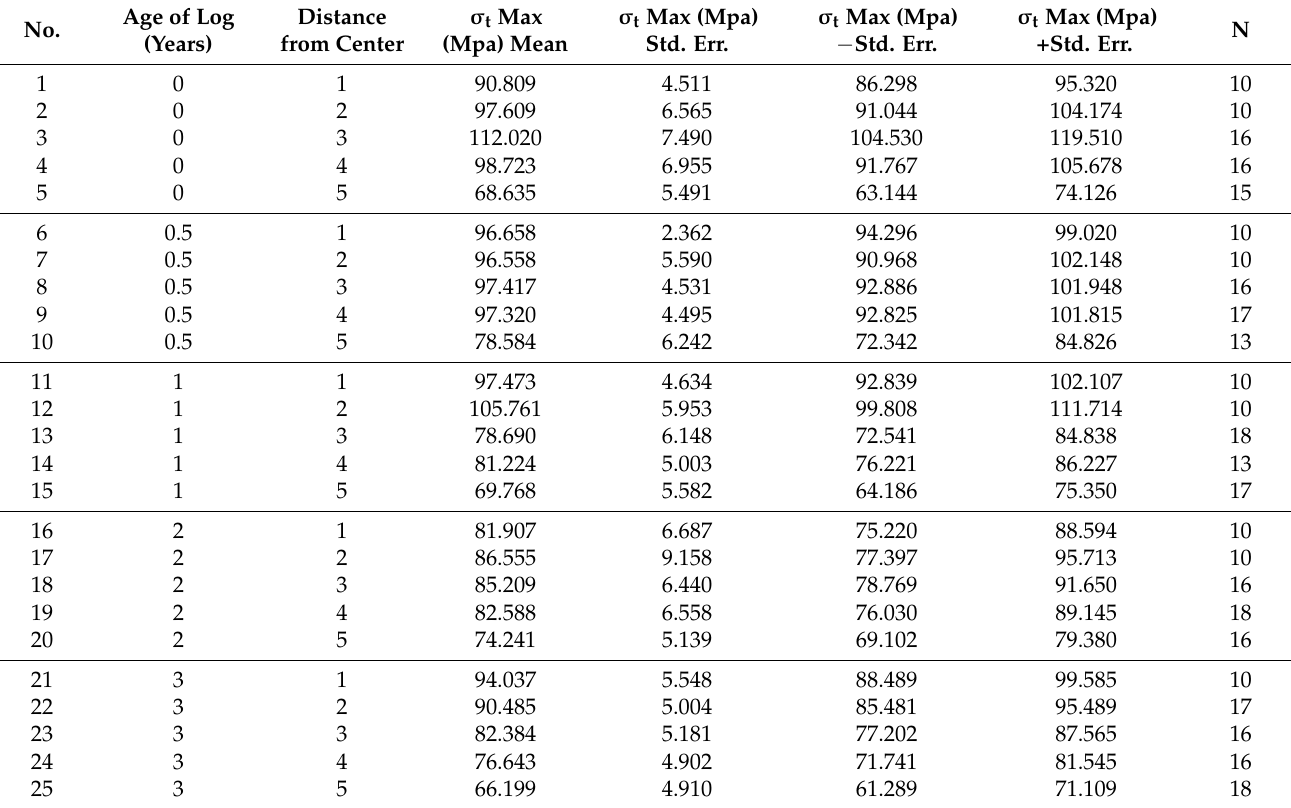
Table 5. ANOVA spreadsheet—Age of log and distance from center—influence on tensile strength.